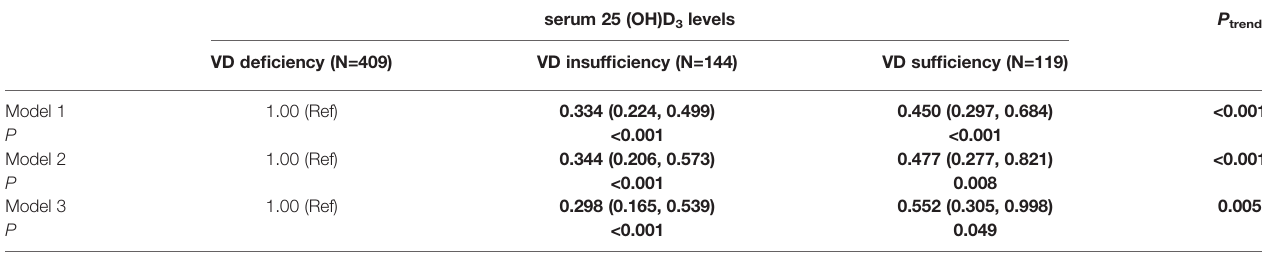
TABLE 2 | Logistic regression analysis of the associations between serum 25(OH)D 3 levels and risk of